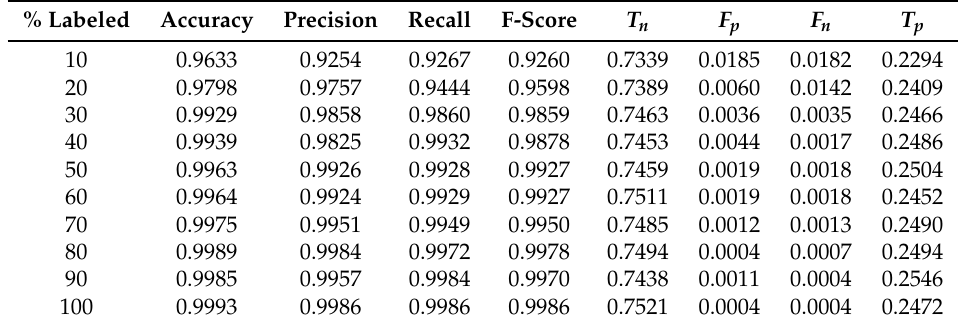
Table 1. Varying of the considered performance metrics versus percentage of labeled datapoints (%